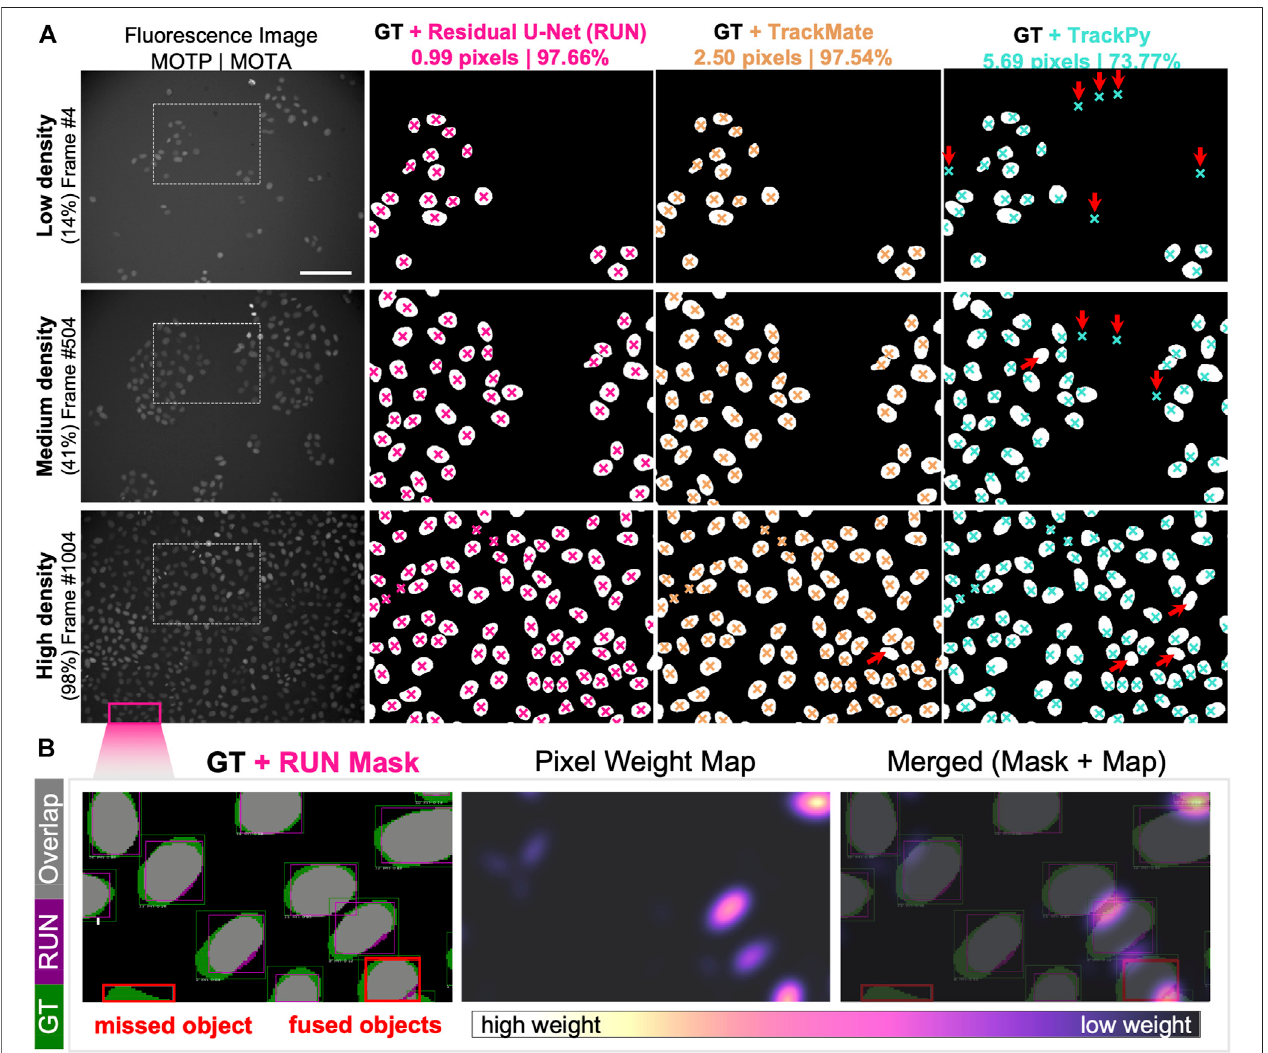
FIGURE 4 | Single-cell Segmentation Performance. (A) Comparison of Residual U-Net (pink), TrackMate (beige) and TrackPy (cyan) algorithms in detecting and localisingcellsinthreerepresentative fi eldsofviewwithlow,mediumandhighcelldensity.Overlaidarethecroppedregionsofgroundtruthsegmentationmaskswithcell centroid markers depicted for zoomed-in region of the original fl uorescence channel image (leftmost column). Cell localisation scores for multi-object tracking precision (MOTP) and accuracy (MOTA) are listed above. Red arrows indicate the presence of false-negative (upward right) and false-positive (downward facing arrow) cell detection errors. (B) Detailed overview of segmentation performance on portion of high cell density fi eld of view. (Left) Per-object bounding boxes indicate visual matchesbetweengroundtruth(GT,green)andResidualU-Netsegmentationmask(RUN,magenta)forintersection-over-unionscorecalculation(overlappingareasIoU, grey). Two typical segmentation error types are highlighted (red boxes), where an object is mis-detected (left) and two separate objects are detected as one instance (right) . (Centre) Pixel weight map designed to prioritise regions between proximal nuclei. Pixel upweighting is indirectly proportional to amount of free space between cell nuclear instances, as demonstrated in the merged image overlap (Right)